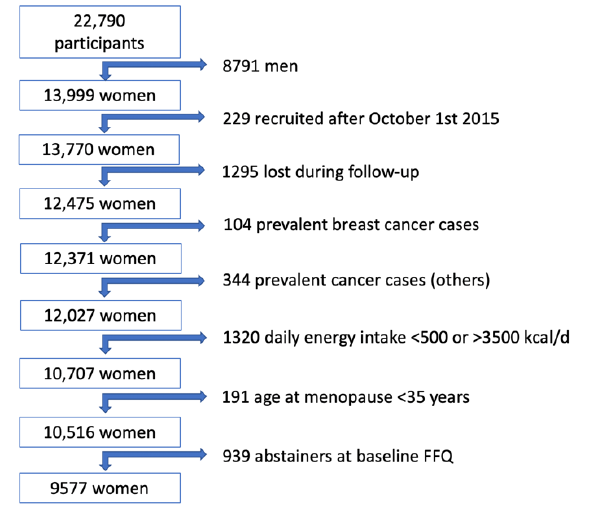
Figure 1. Flowchart of participants in the SUN Project, 1999 – 2018.